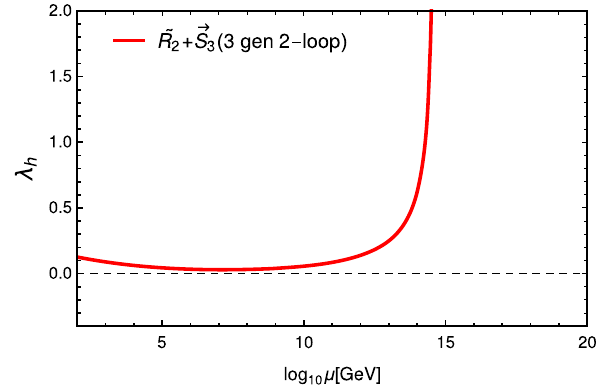
Fig. 11 Running of Higgs quartic coupling λ h for three generations of (cid:2) R + S 2 3 atthetwo-looplevel.Here,alltheleptoquarkYukawacouplings are assumed to be 1.0 and all the Higgs-leptoquark couplings are taken to be 0.01. In this model, λ h diverges at an energy scale ( ∼ 10 14 . 4 GeV) far below the Planck scale at two-loop